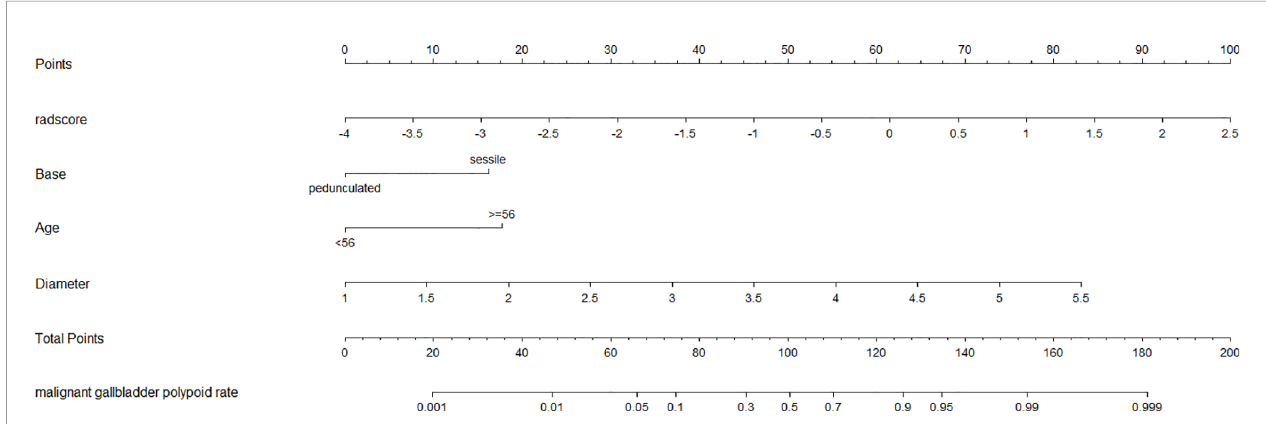
FIGURE 5 | The developed nomogram based on combined